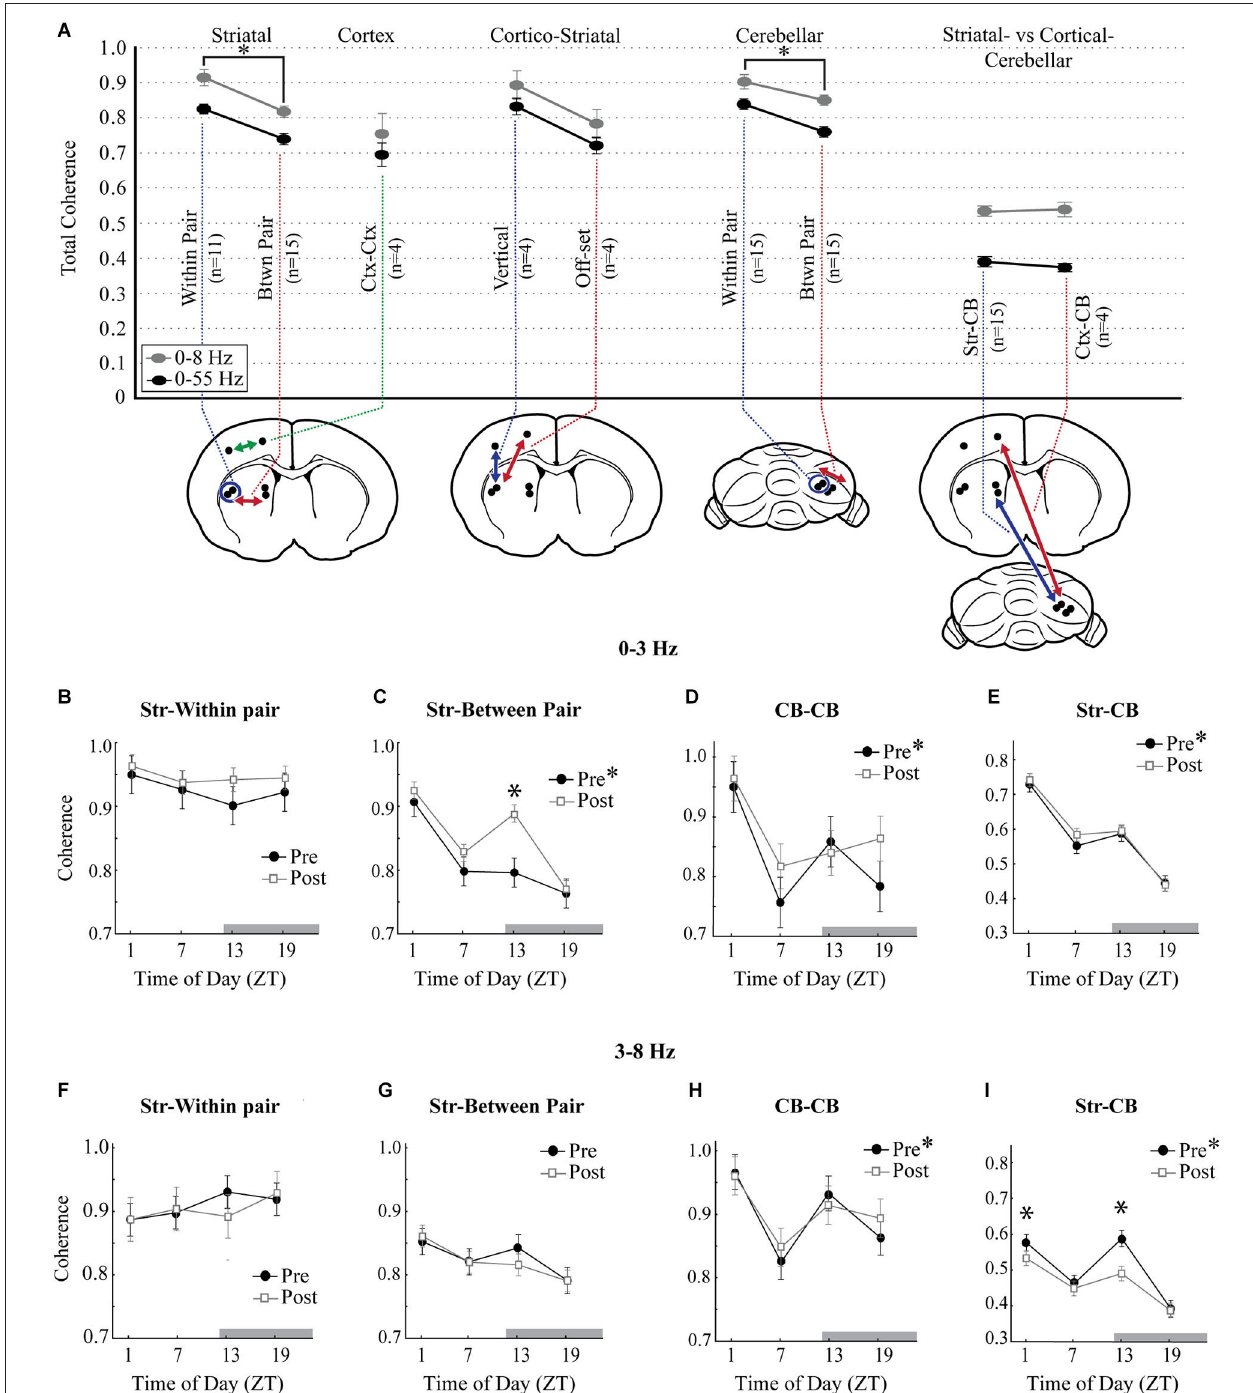
p < 0.05. (B–E) 0–3 Hz coherence measured across each of the striatal and cerebellar comparisons showing diurnal variations at baseline (filled circles) and the effects of raclopride (open squares). (F–I) Coherence measures at baseline and after raclopride in the 3–8 Hz band, across each of the striatal and cerebellar comparisons. Asterisks in the figure legend indicates a main effect of ZT at baseline (pre-raclopride), asterisks above the data points indicate significant effects of raclopride in the Tukey post hoc analysis, p <